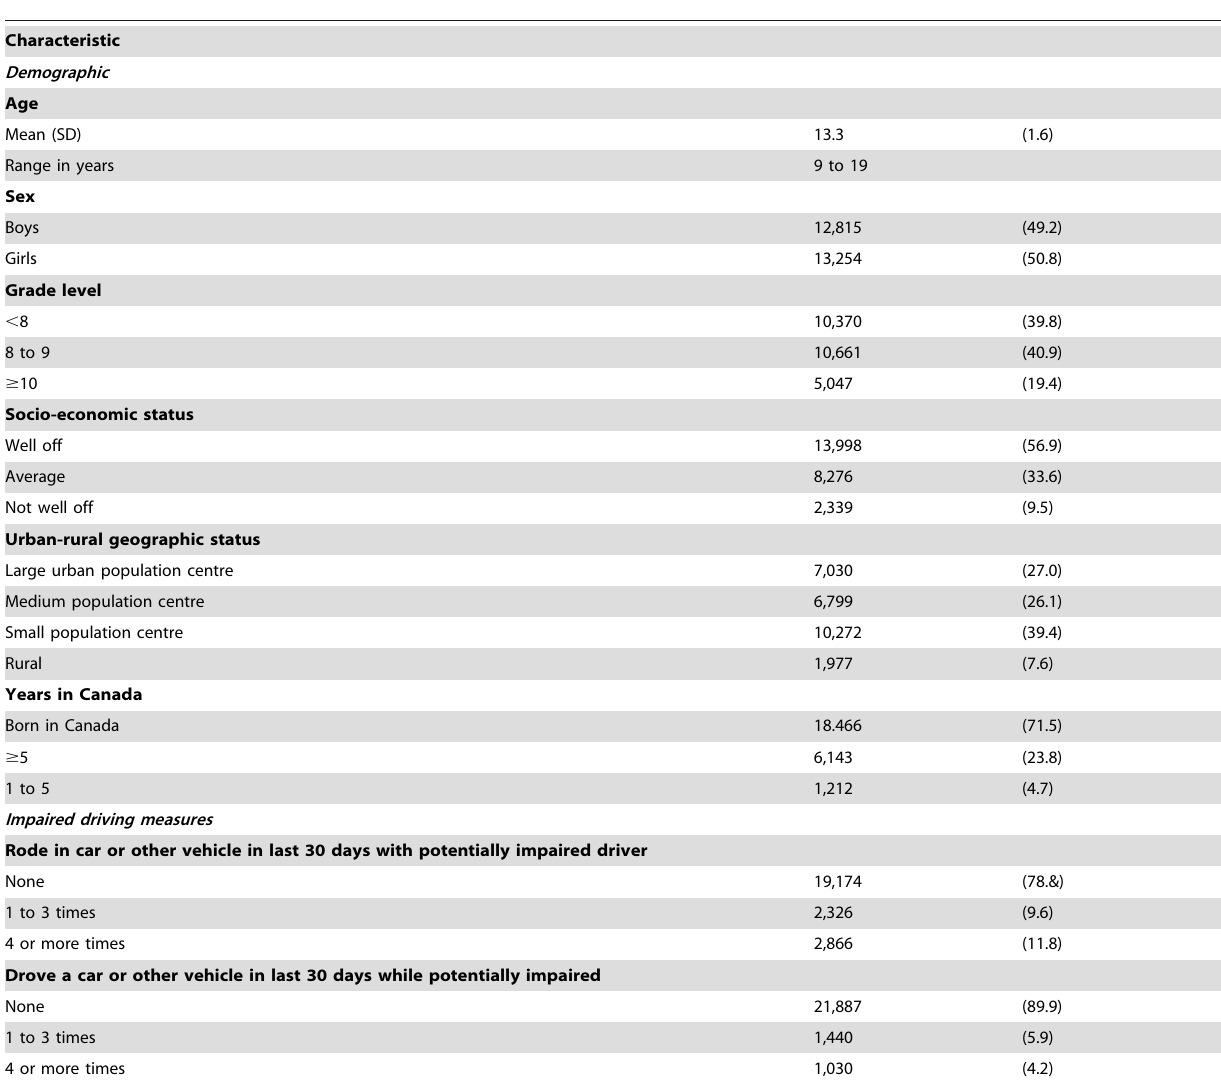
Table 1. Characteristics of student sample in the 2010 Canadian HBSC